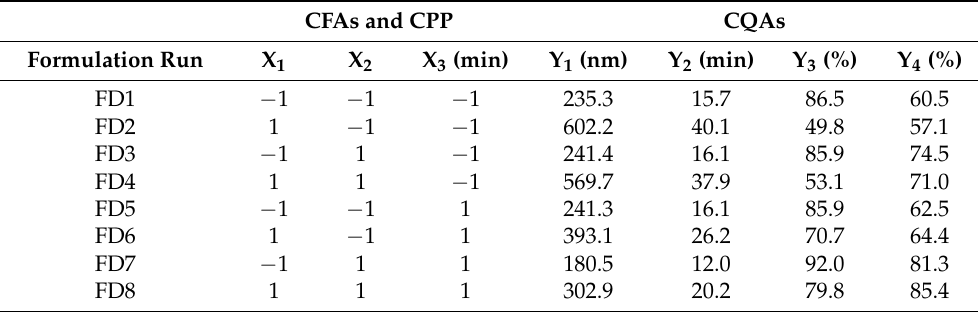
Table 4. 2 3 FbD. The eight formulation batches and their results mean particle size of spanlastics (Y 1